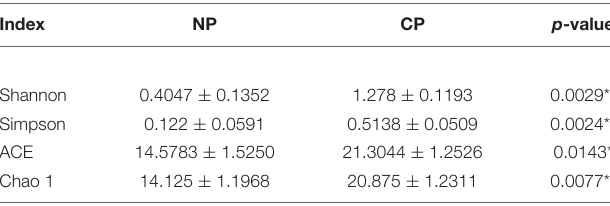
TABLE 1 | Comparison of alpha-diversity indices of gut bacterial community structure in fall armyworm larvae.